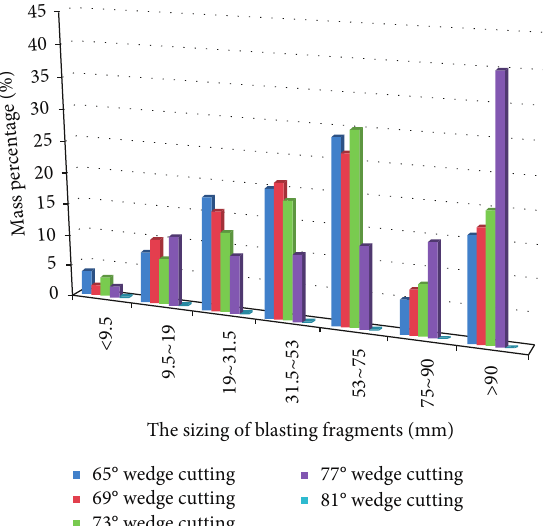
Figure 13: Histogram of blasting fragments of wedge-shaped recessed model at different angles.